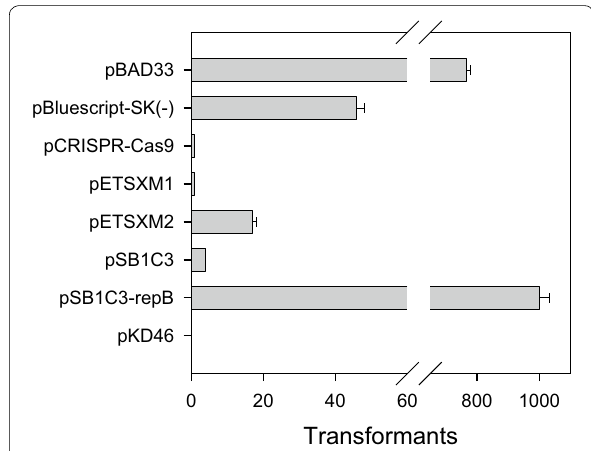
Fig. 1 Transformants in MR‑1 with different vectors. The transformants are counted by colony foaming unit (CFU)